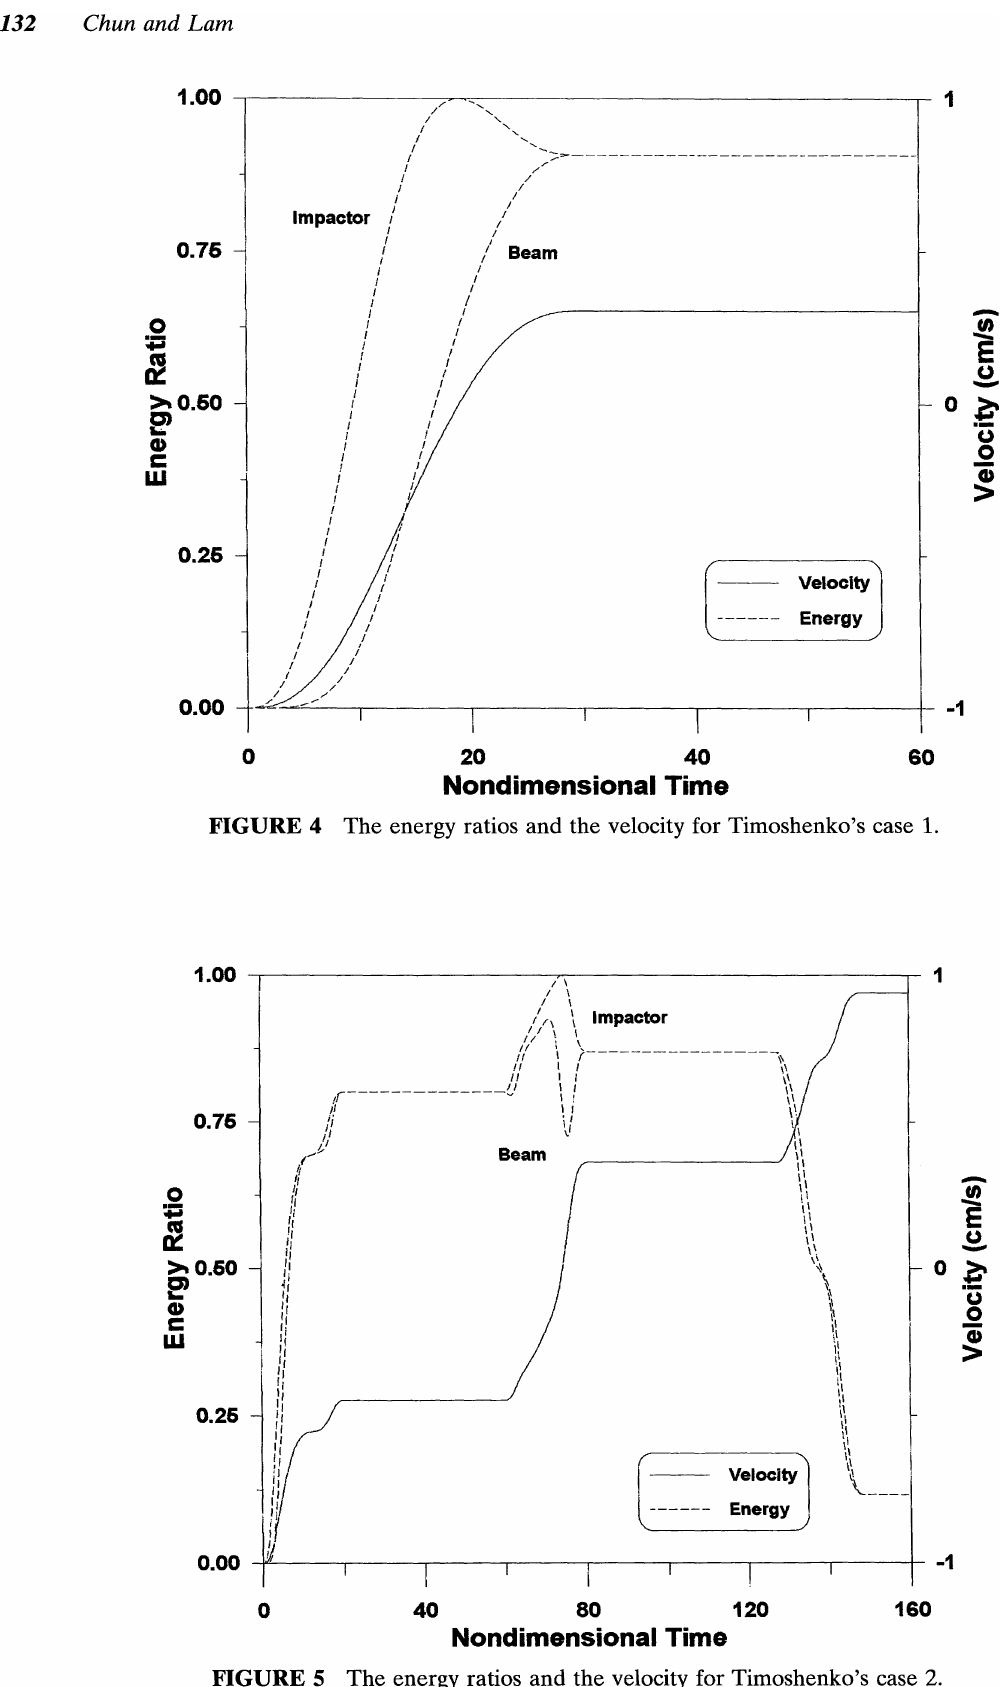
FIGURE 5 The energy ratios and the velocity for Timoshenko's case